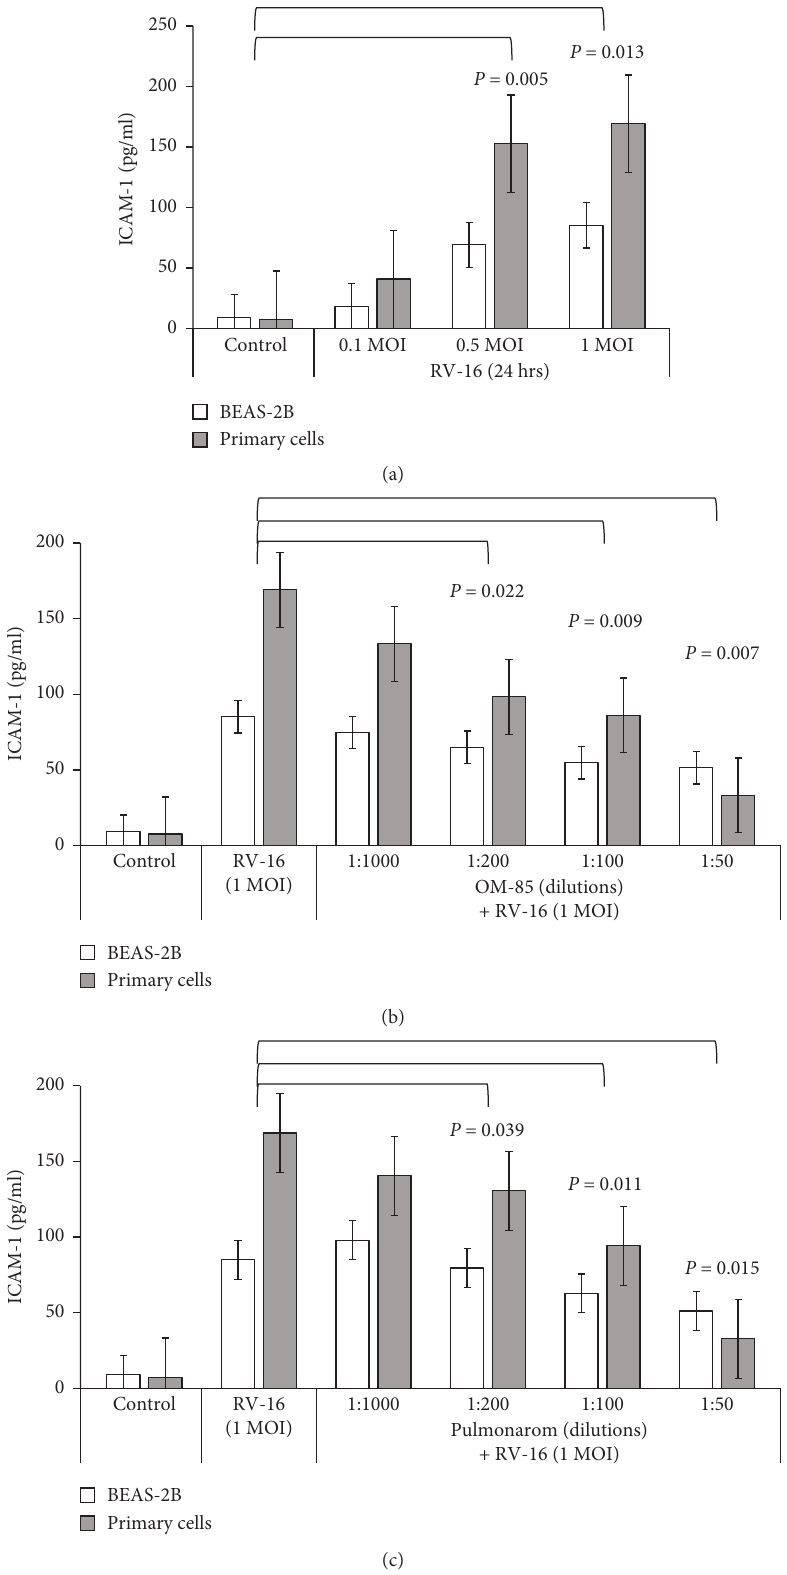
Figure 3: ICAM-1 expression. (a) ICAM-1 expression by BEAS-2B and primary cells infected by 1.0, 0.5, or 1.0 MOI RV-16. (b) The concentration-dependent effect of OM-85. (c) Pulmonarom on ICAM-1 expression by BEAS-2B and primary